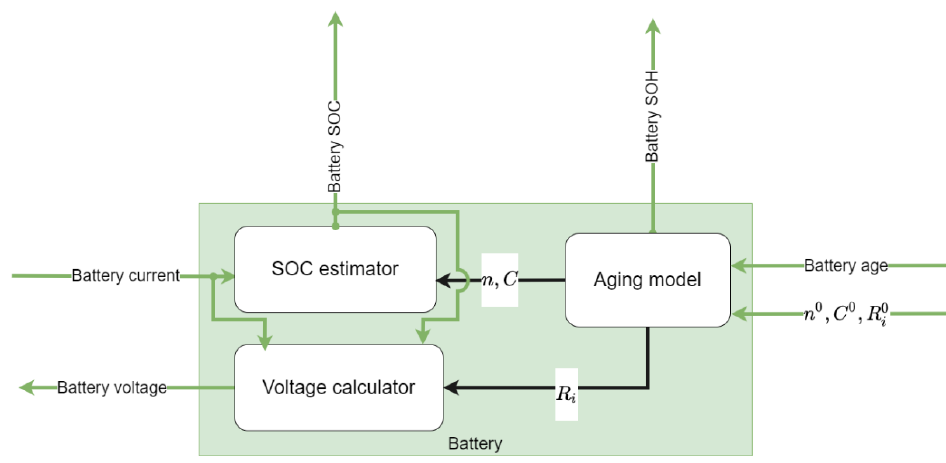
Figure 5. Details of the battery block.